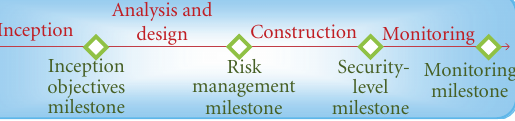
Figure 4: The phases and milestones of